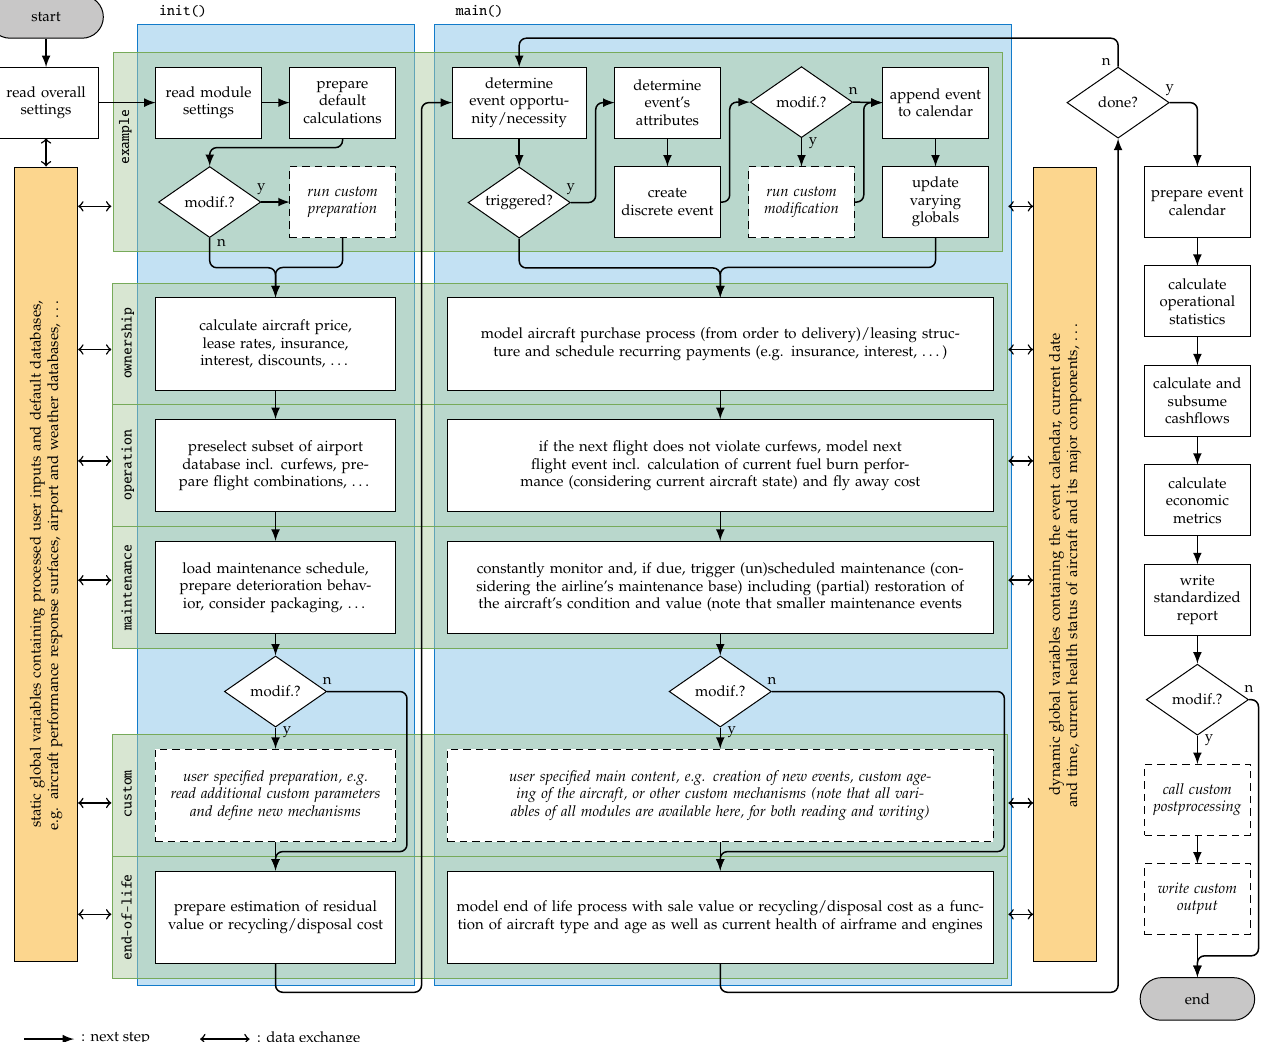
Figure 3. Modular program structure of AirLYFE with individual modules in green, their initialization and main functions in blue, databases in orange, and optional (i.e., user specified) procedures in dashed